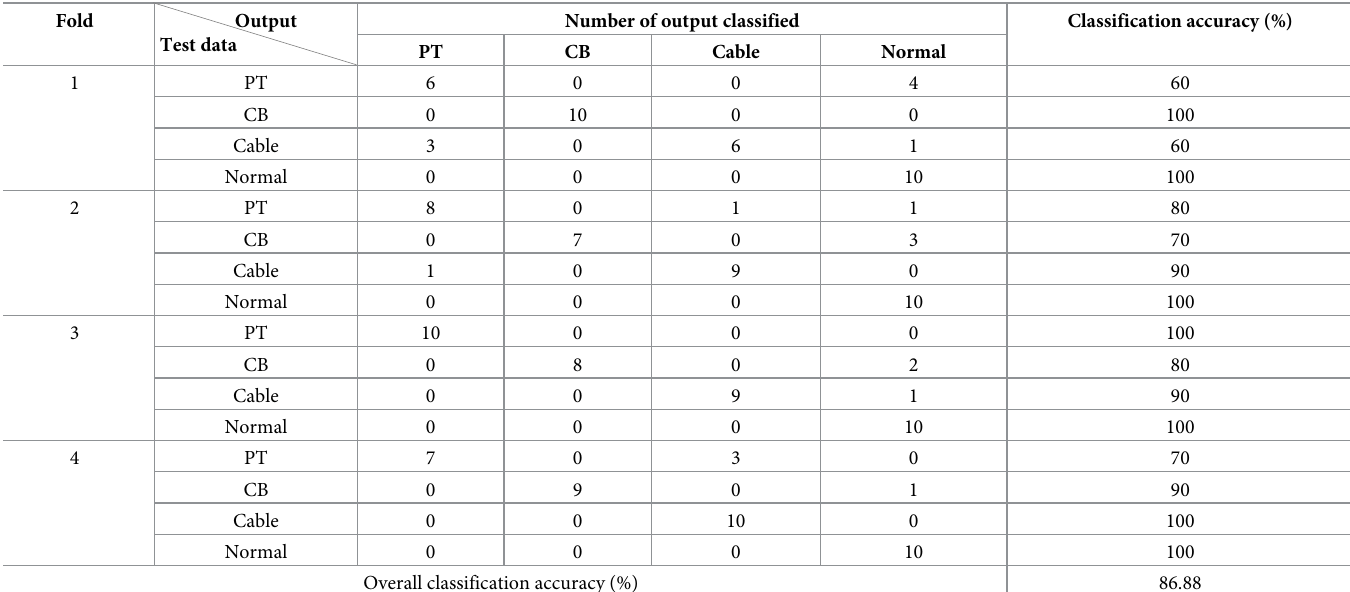
Table 5. Classification results using SVM based on 4-fold cross validation.